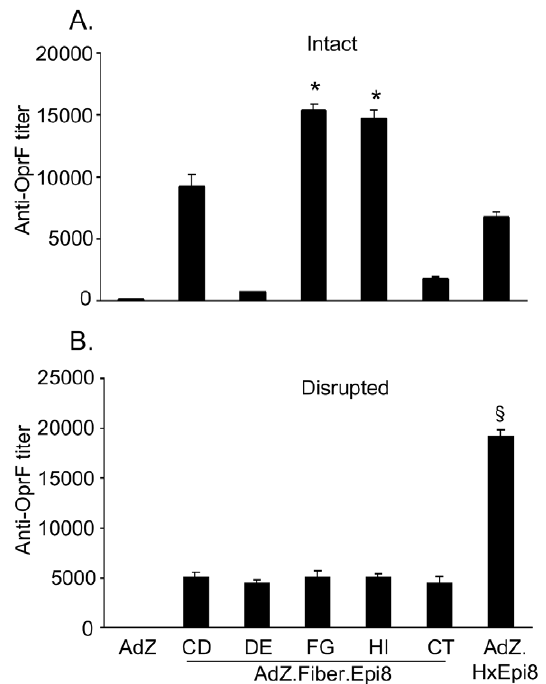
Figure 4. Surface presentation of Epi8 epitope on capsid- modified Ad vectors. ELISA plates were coated with A. intact or B. disrupted AdZ.F(CD)Epi8, AdZ.F(DE)Epi8, AdZ.F(FG)Epi8, AdZ.F(HI)Epi8, AdZ.F(CT)Epi8, AdZ.HxEpi8 or AdZ (10 10 pu/well) and probed with anti- OprF serum. Data are shown as the mean 6 SEM of 3 wells/vector.* denotes p , 0.05, AdZ.F(FG)Epi8 or AdZ.F(HI)Epi8 compared to all others. 1 denotes p , 0.05, AdZ.HxEpi8 compared to all others.